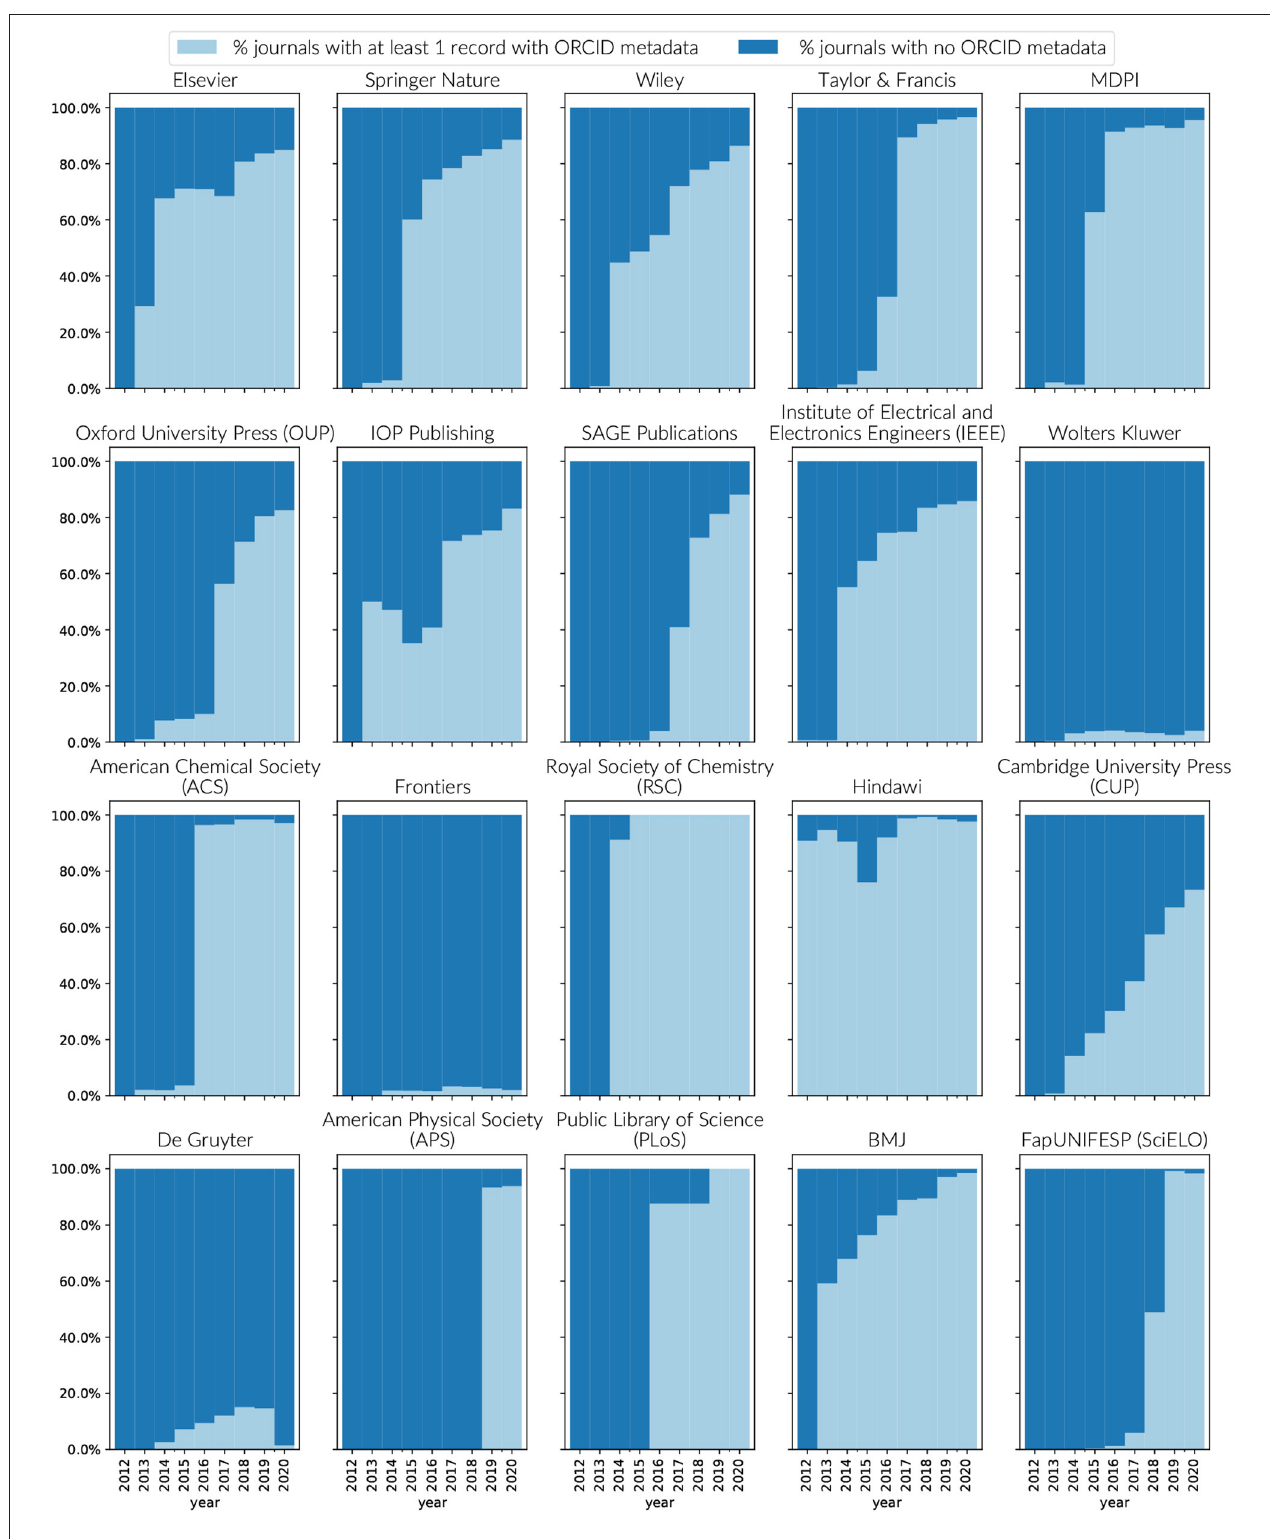
FIGURE 8 | Journals supporting the use of ORCID’s within Crossref metadata by publisher by year. To be counted as supporting ORCID, a journal must have at least one record in Crossref that includes an ORCID iD in its metadata. Source: Crossref public file matched to Dimensions.